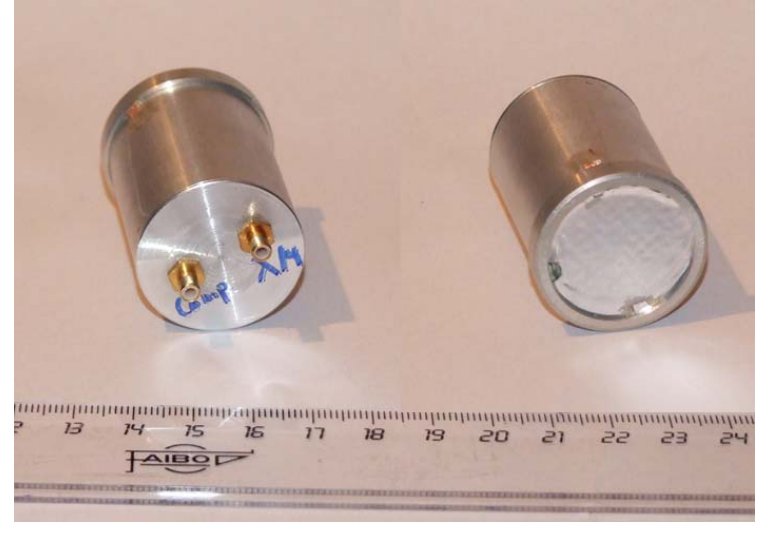
Figure 3. Pictures of rear (left) and front (right) faces of the prototypes of the proposed air-coupled transducer with active polypropylene foam matching